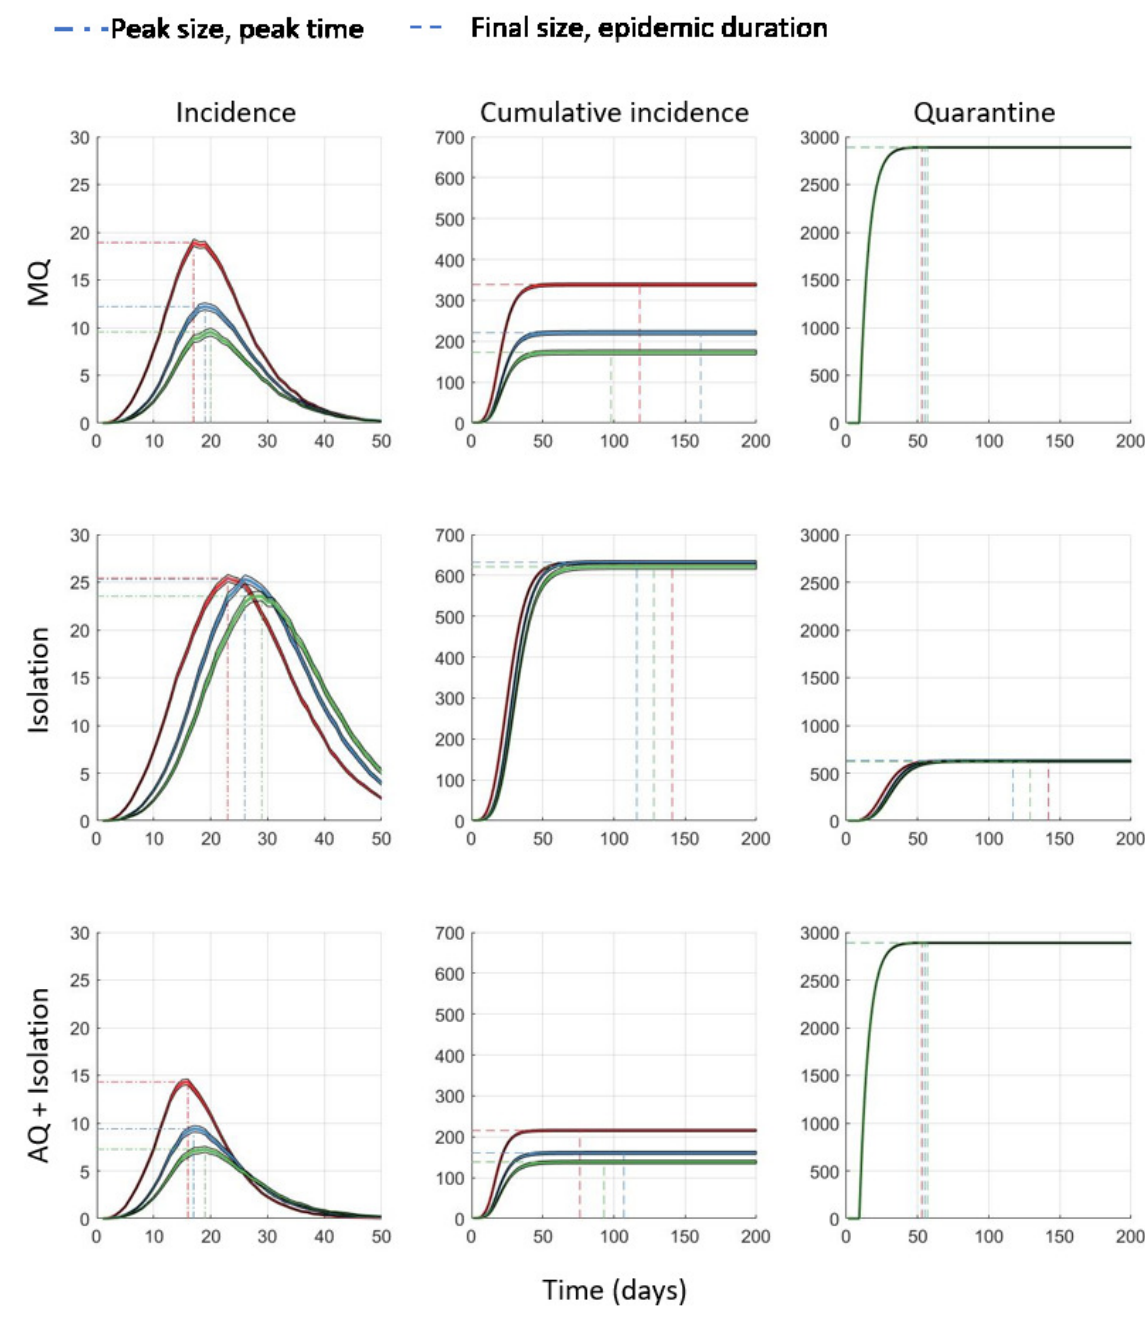
Figure 5. Incidence, cumulative incidence, and cumulative quarantined individuals are compared under three interventions. For each intervention, 1000 runs are simulated and the time series of average are displayed under three index cases. Clearly, AQ + Isolation is the most effective intervention (significant reduction in both incidence and cumulative incidence as shown in the bottom